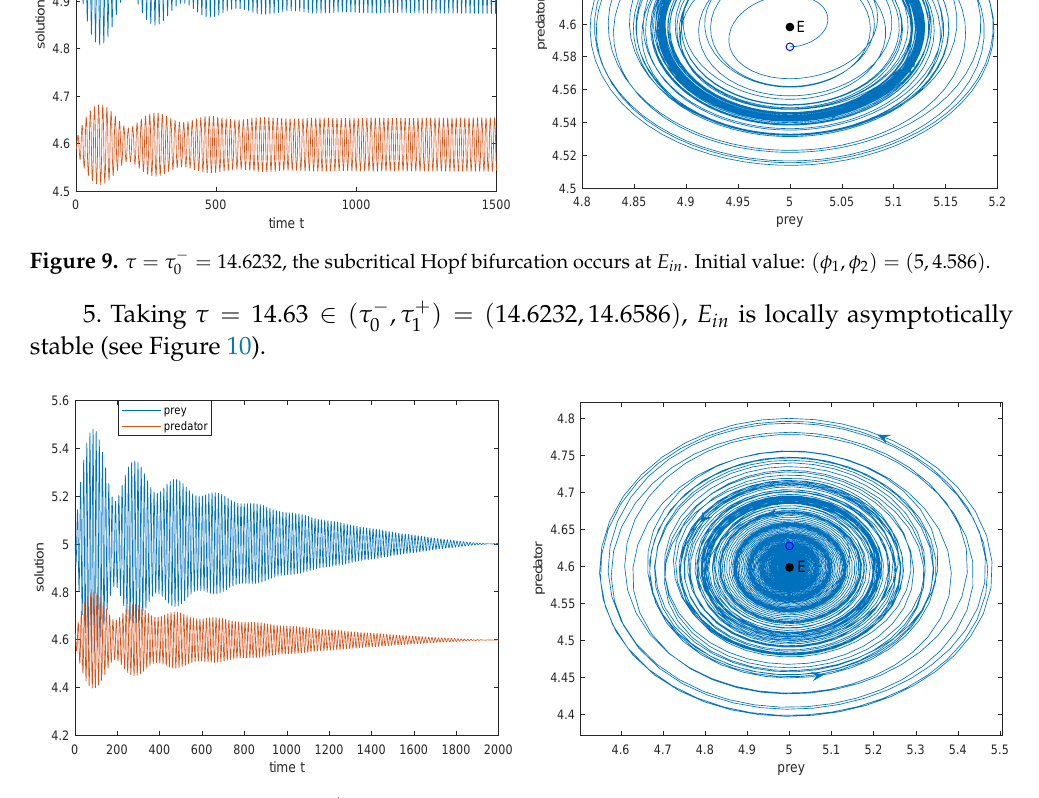
Figure 10. τ = 14.63 ∈ ( τ − ( φ 1 , φ 2 ) = ( 5,4.627 ) .